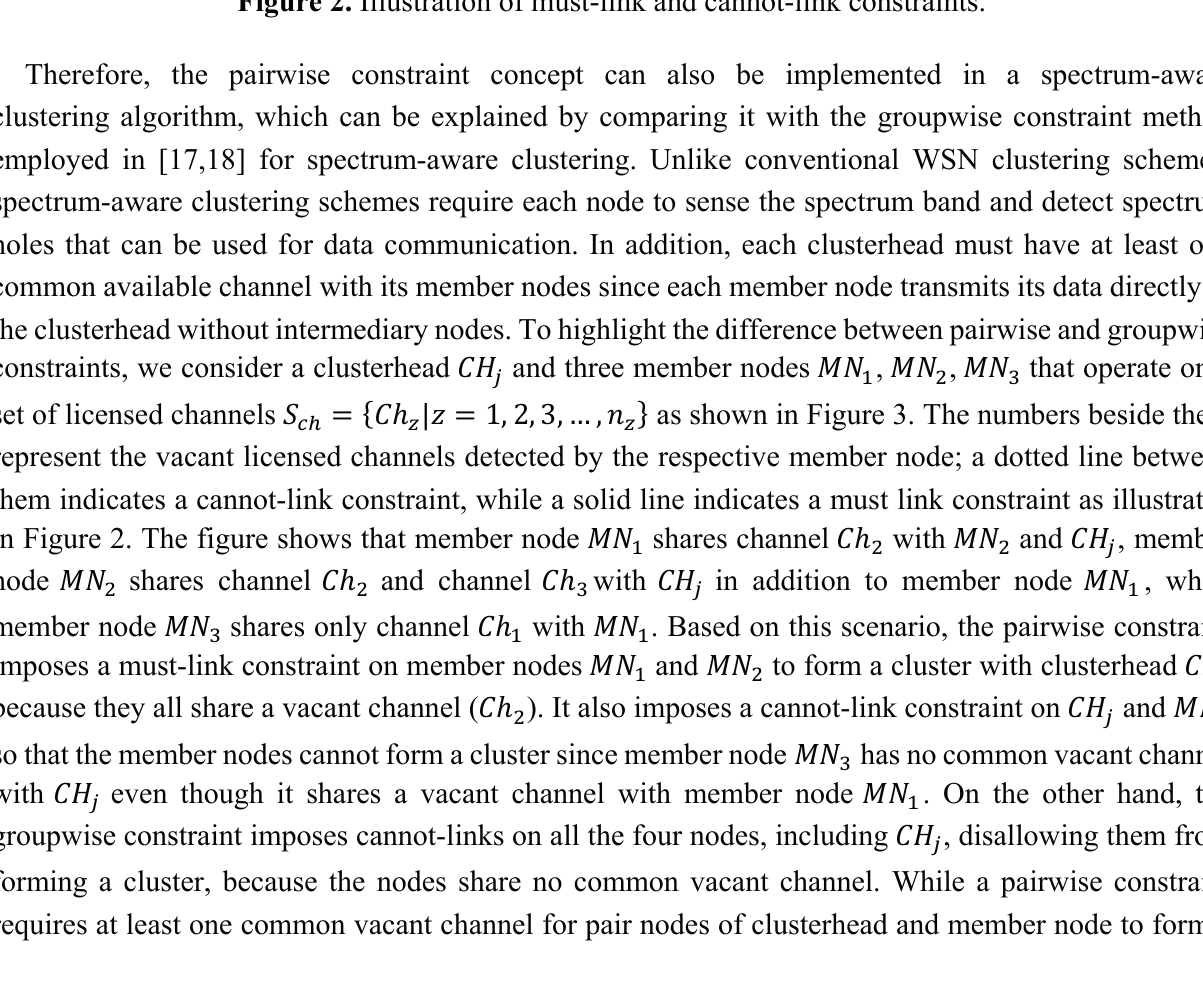
Figure 2. Illustration of must-link and cannot-link